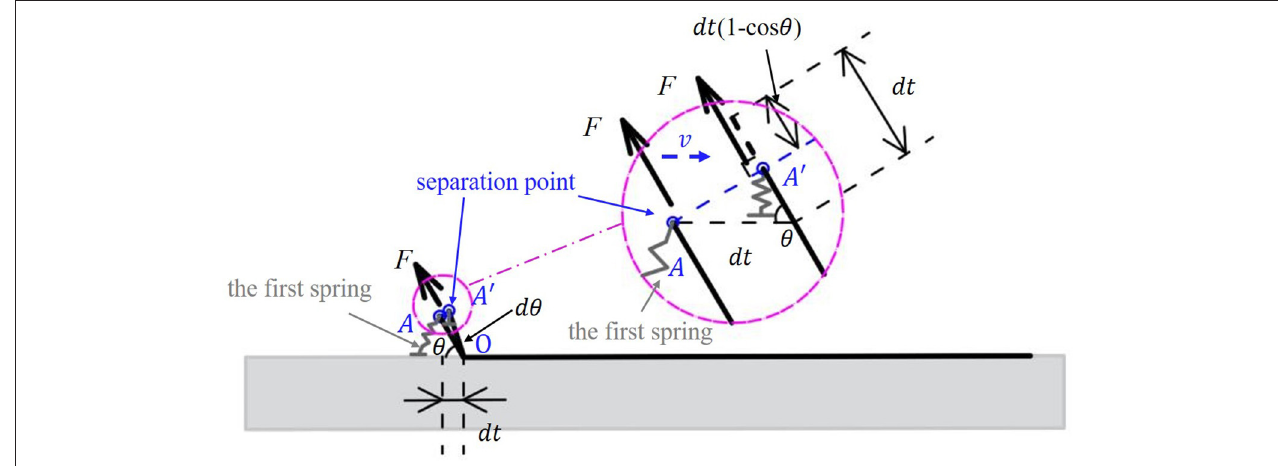
TABLE 1 | Parameters determined by the experiments [cited from Pesika et al. (2007) ] or derived from theoretical models. γ (N / m) Data marked with * is an estimated value from the Kendall equation or PZ model.